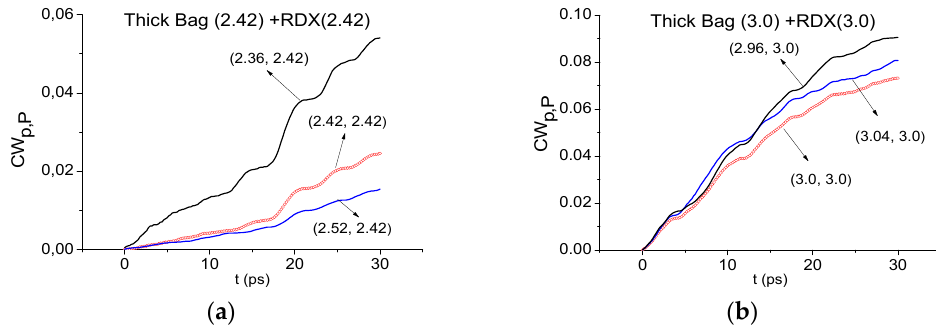
Figure 7. Time-dependent integral characteristic CW p,P ( t n ) calculated for the frequencies ν = 2.42 THz ( a ); 3.0 THz ( b ) if the modified integral criterion is applied for the Thick Bag signal and RDX_Air as a standard signal.